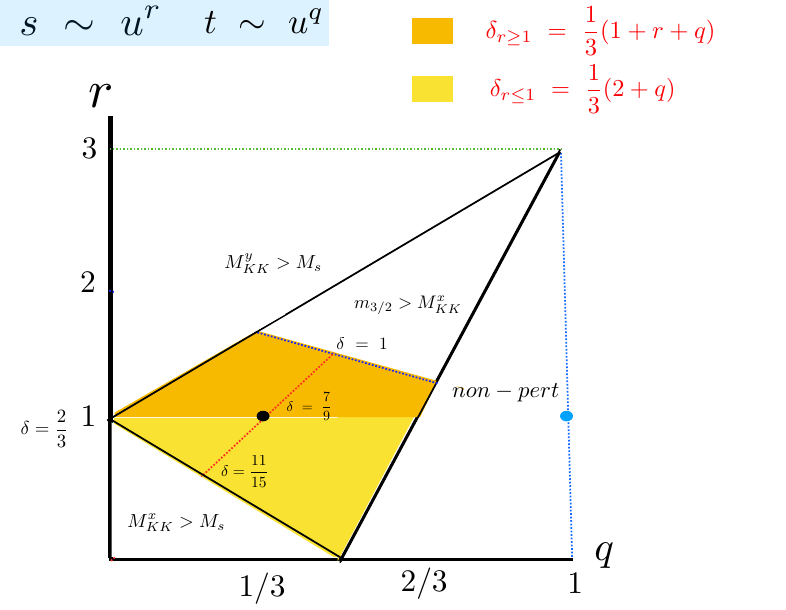
Figure 1 . Scales in the asymptotic limit u → ∞ with s ∼ u r , t ∼ u q . Each point in the plane ( r, s ) means one possible field